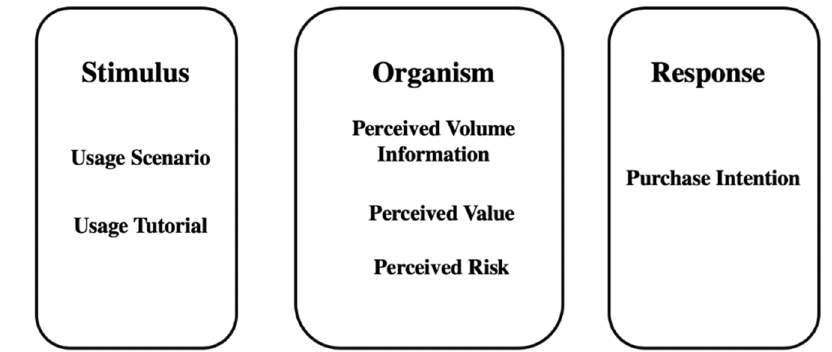
Figure 2. Conceptual framework.